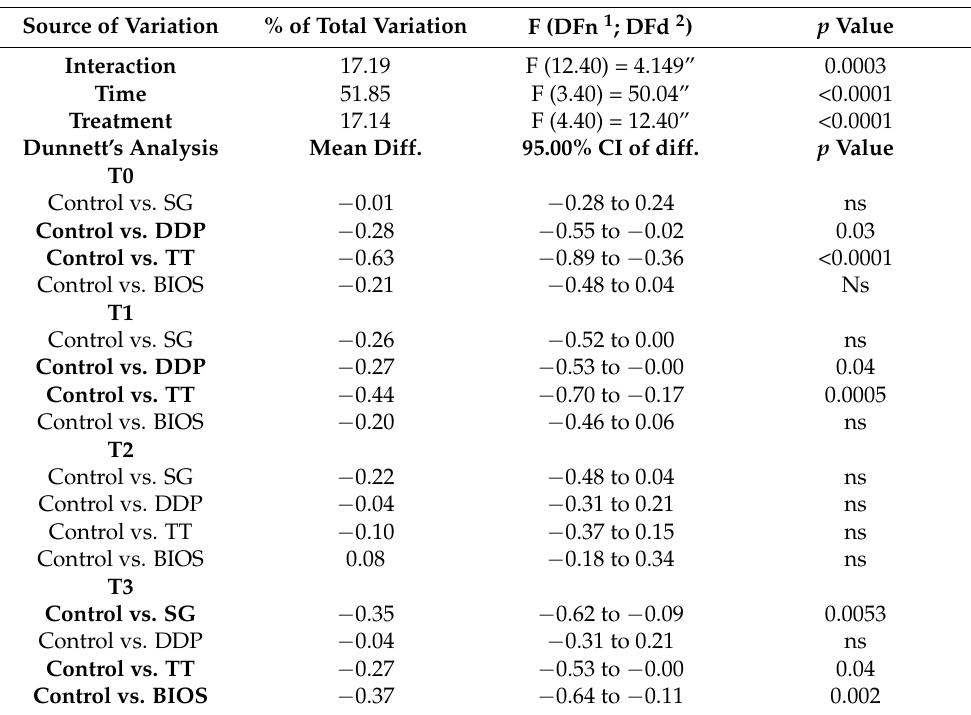
Table 2. Summary of the two-way ANOVA comparison and Dunnett’s multiple comparison test considering the exposure to the different